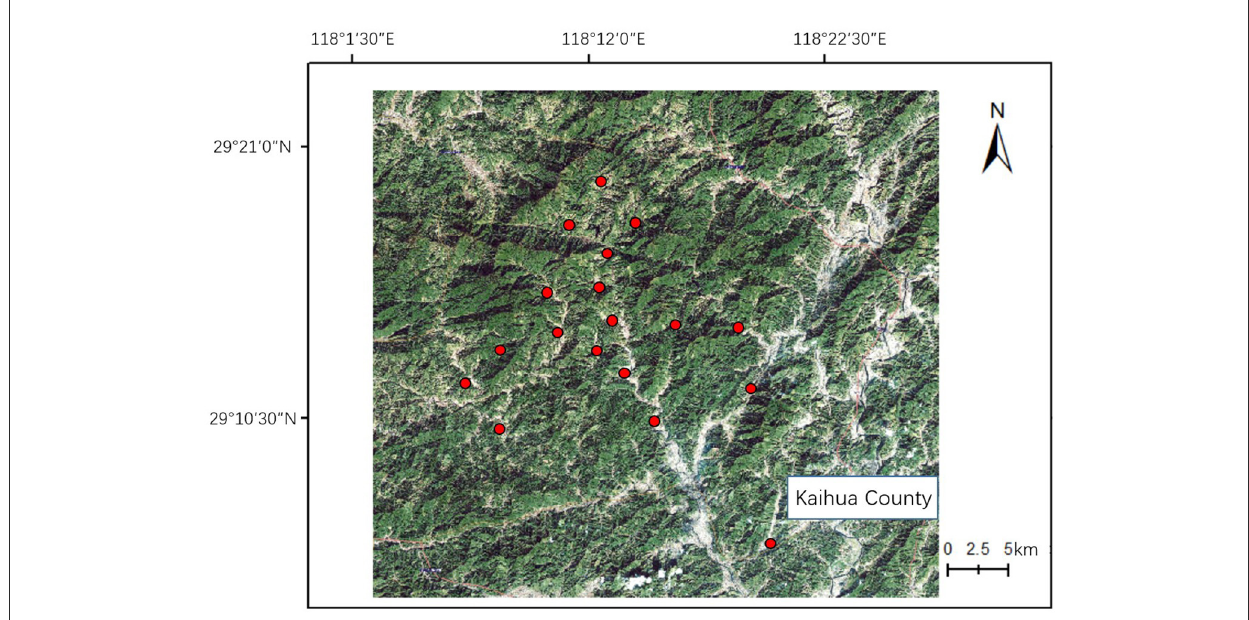
FIGURE1 The 18 research sites located in Kaihua County, Zhejiang Province